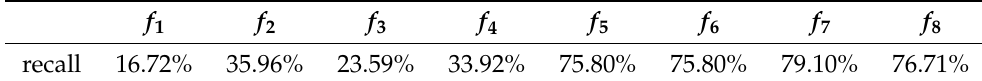
Table 6. Weighted recall on dataset A for feature sets f 1 – f 8